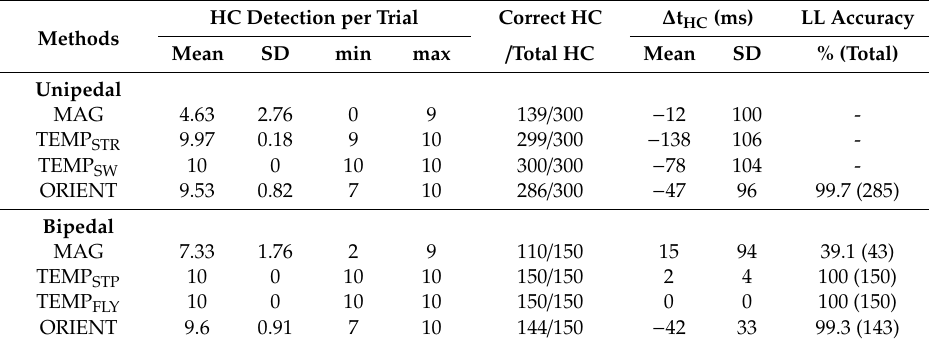
Table 2. Hurdle clearance and leading leg detection results for both unipedal and bipedal configurations. In total, 15 trials with each N hurdles = 10 hurdle clearances were available for the performance analysis.